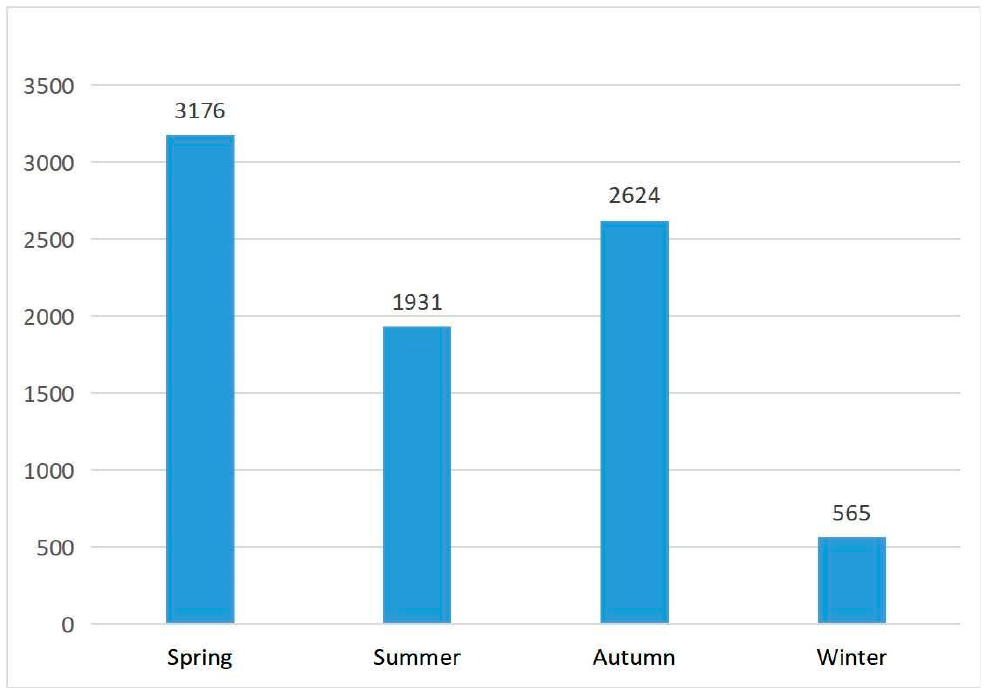
Figure 7. Statistics of the number of jogging trajectories in different seasons (full-sampled).